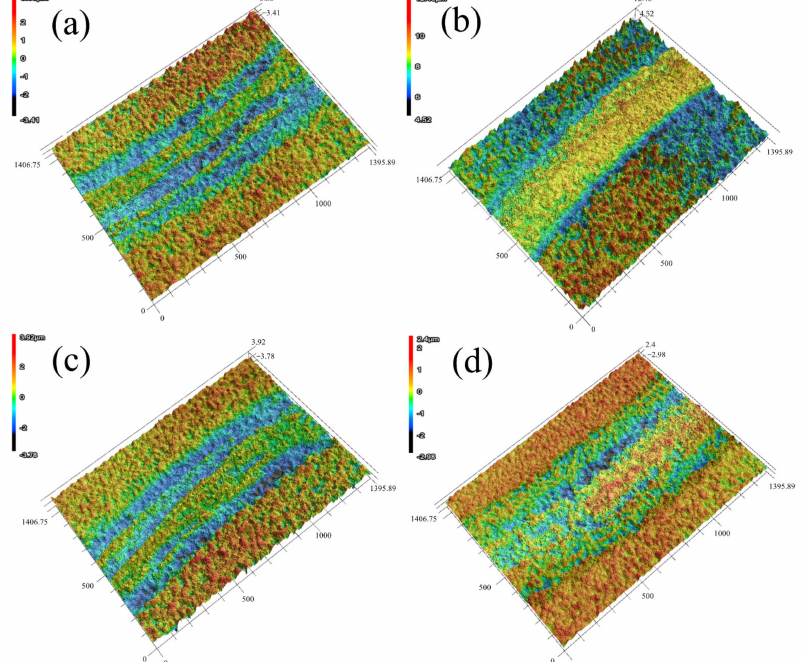
Figure 10. Three-dimensional morphology of abrasion marks of coatings at different bias voltages: